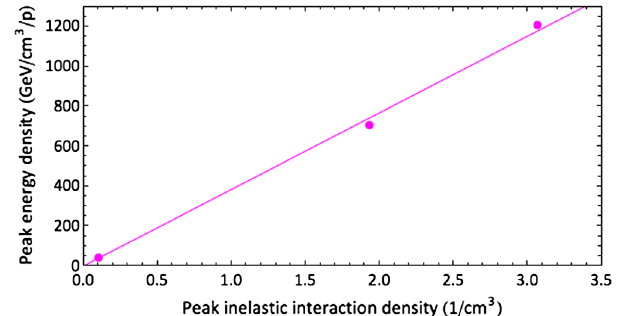
FIG. 23. Correlation between the peak energy density normal- ized per proton and the peak probability density of inelastic interactions in the TCT for threshold 1 in the simulated cases (from left to right: Case 1, Case 3 and Case 2). The line represents the fit function x ¼ bz